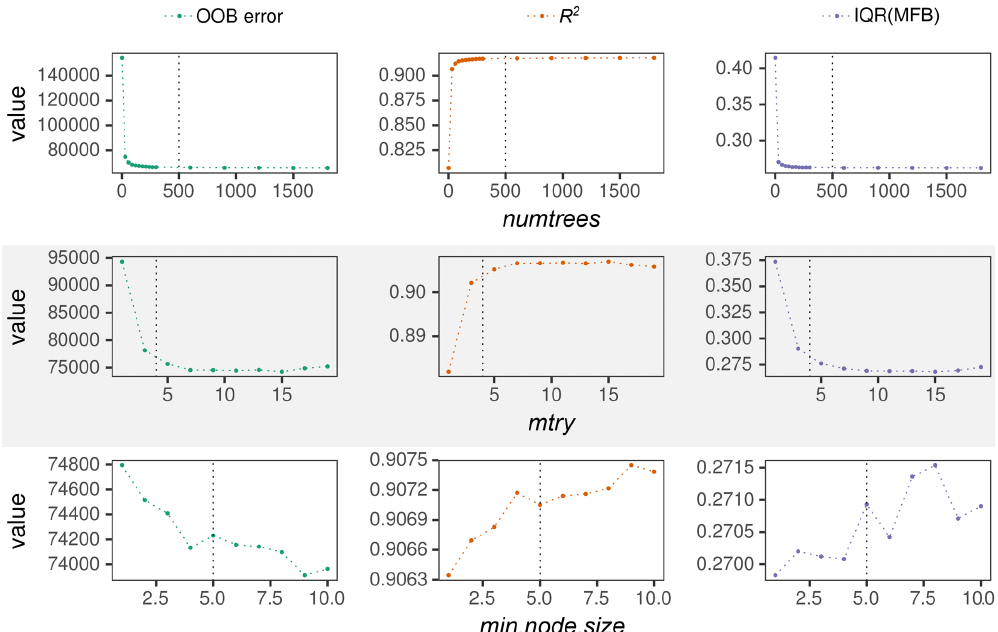
Figure 4. RFRM evaluation through OOB error (green), R 2 (orange), and IQR(MFB) (purple) with varying hyperparameters. The hyper- parameters are (from top to bottom): numtrees , mtry , and min.node.size . Default hyperparameters for each trained model are as follows: numtrees = 500, mtry = 4, and min.node.size = 5 – also shown with the vertical black dotted lines when the corresponding default value has been